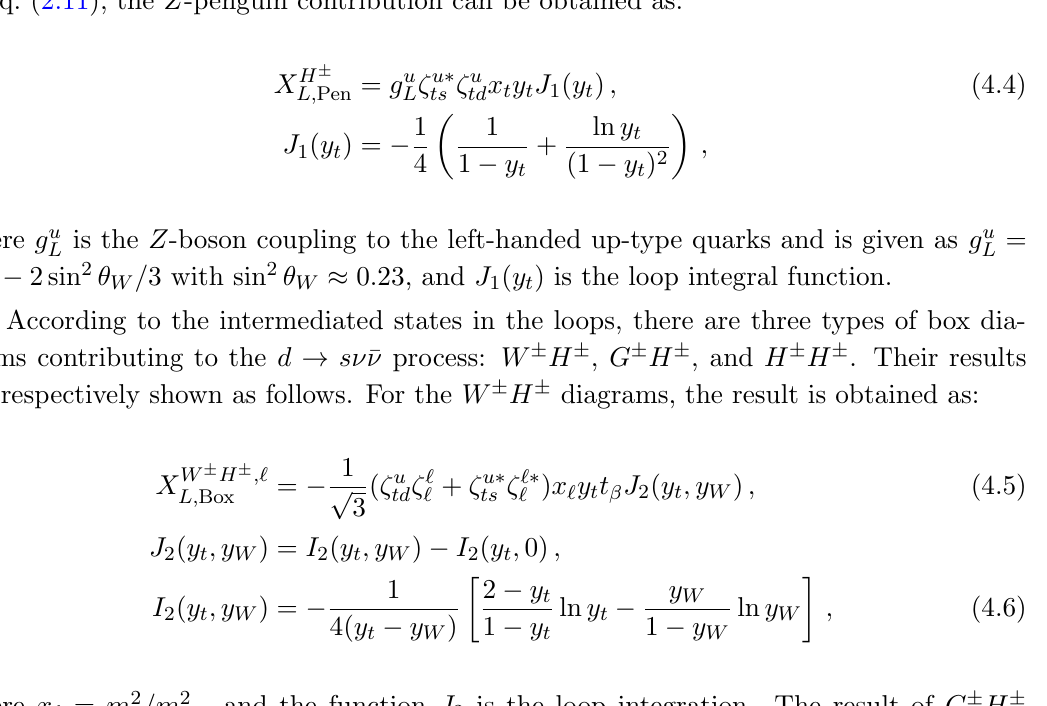
(cid:25) (cid:22) (cid:23)(cid:23) !